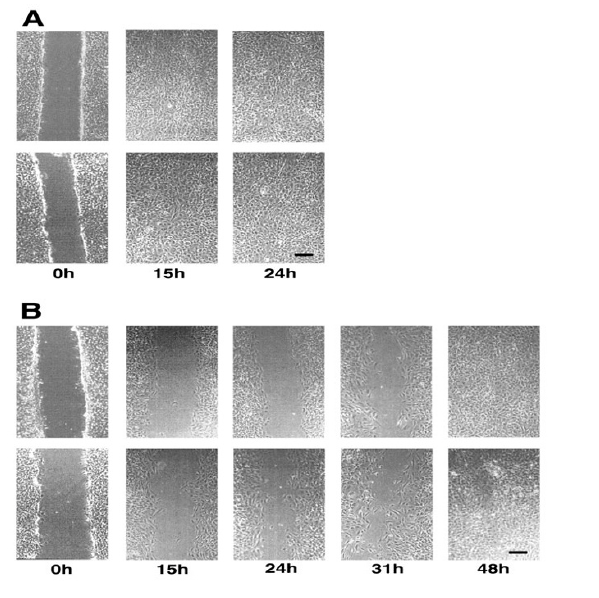
(B) cultured in the absence (upper panel) or presence (lower panel) of mitomycin C. Wounded monolayers of wild-type (A) and SPARC-null fibroblasts (B) were cultured in the absence (upper panel) or presence (lower panel) of mitomy- cin C and monitored for wound closure. Wound repair is not affected by the presence of mitomycin C, an inhibitor of cell mitosis. Scale bar, 62.5 µ